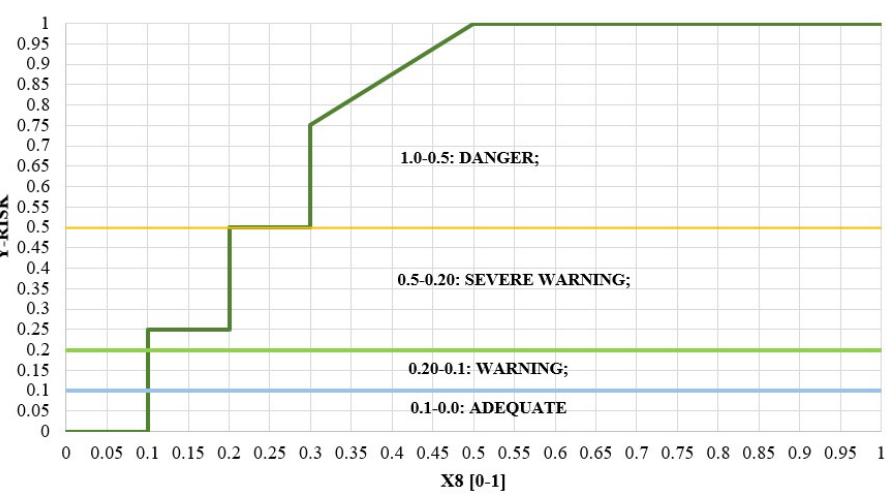
Figure 6. Determination of Y parameter.